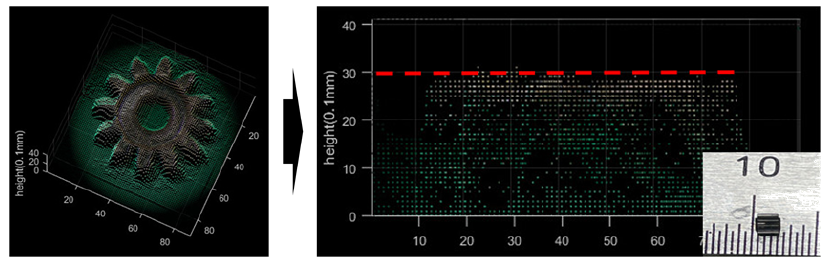
Figure 10. Real-distance 3D model of micro